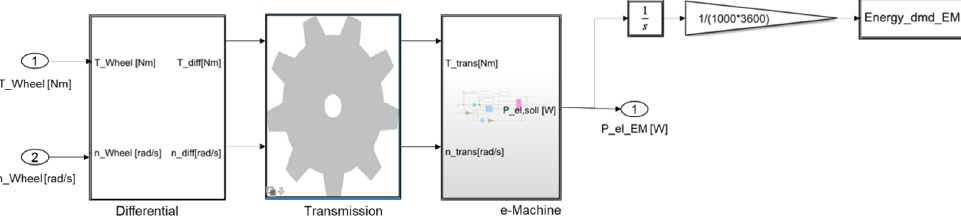
Figure 3. Inside view of the electric powertrain block.